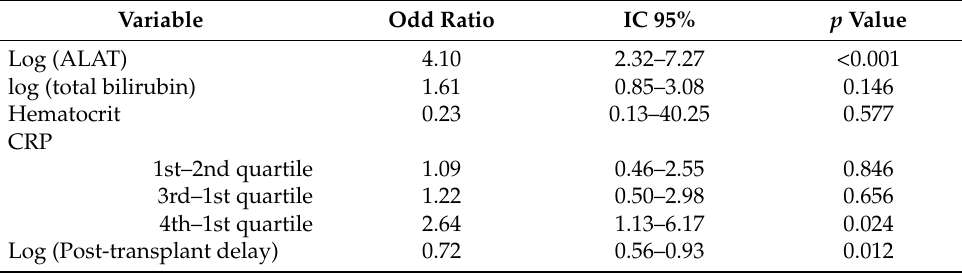
Table 4. Generalized logistic mixed model for the identification of determinants of tacrolimus overexposure.